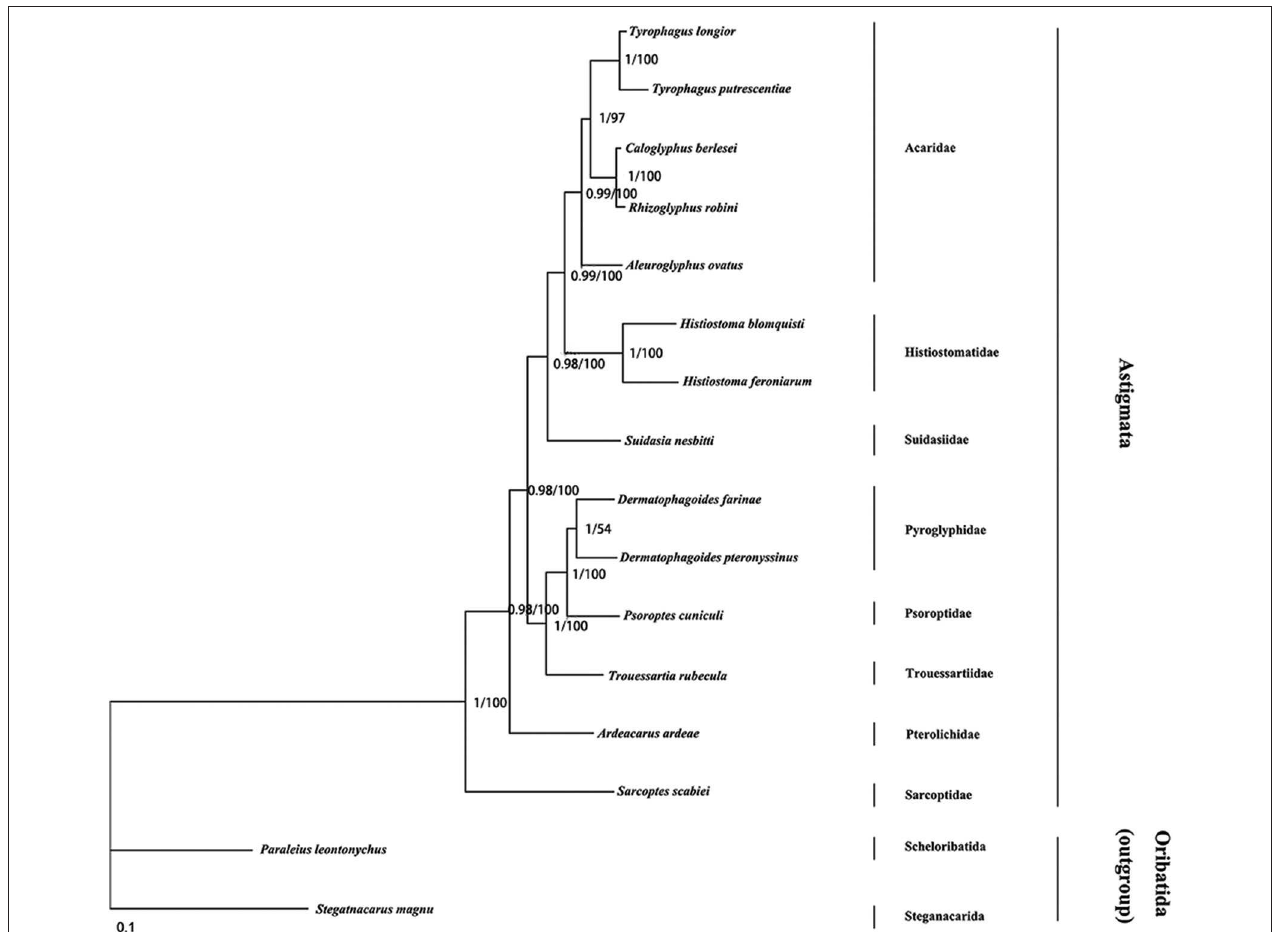
FIGURE 2 | Phylogenetic tree of Astigmata relationships inferred from mitochondrial genome sequences using maximum likelihood and Bayesian methods. Trees was inferred from nucleotide Trees were rooted with two outgroup. Numbers at each nodes are percentages from Bayesian posterior probabilities (left) and ML bootstrapping (right). GenBank acc. Nos. for different Astigmata and outgroup taxa mt genomes are listed in Supplementary Table 1 .